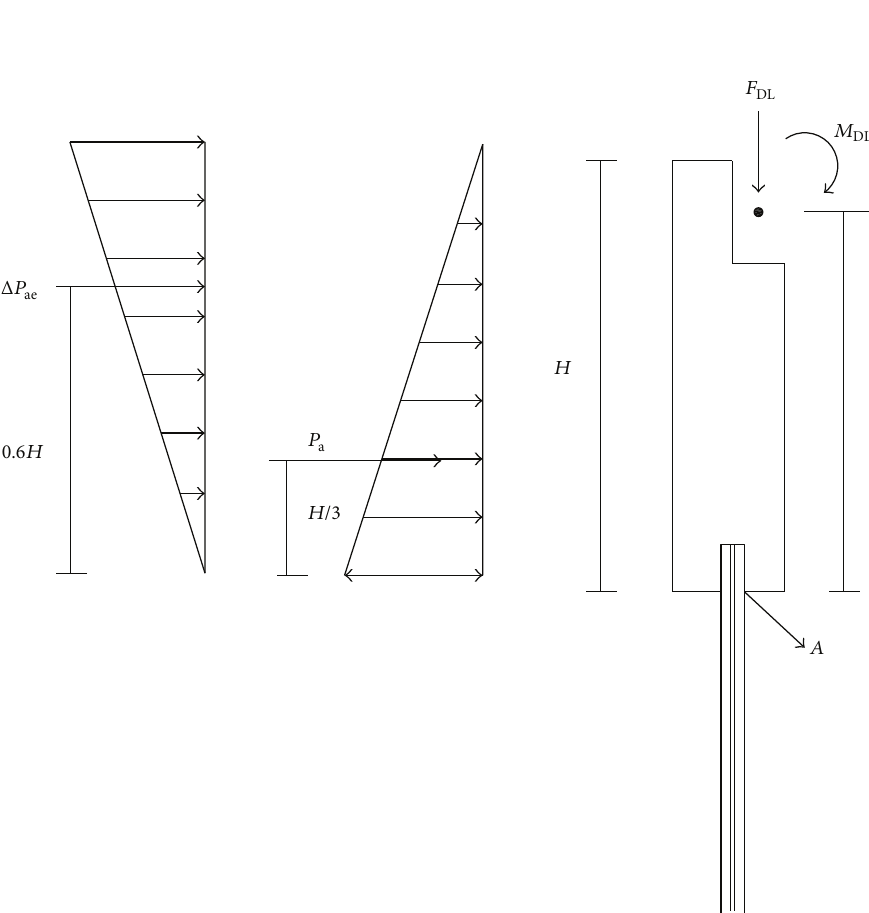
Figure 2: Longitudinal section of the IAB.